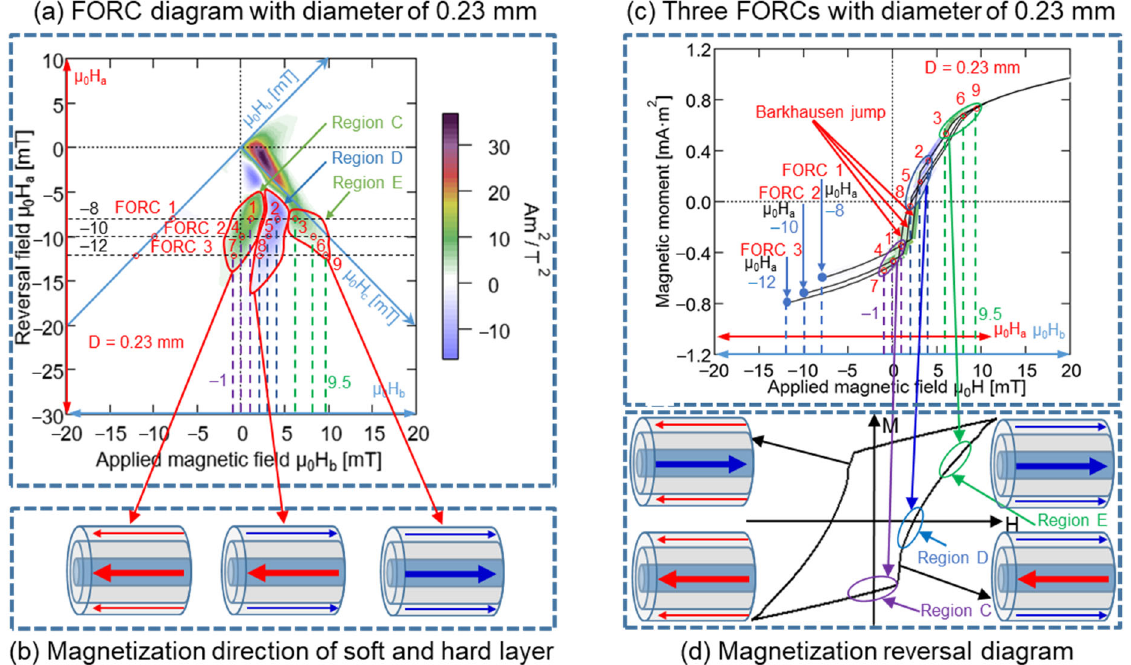
Figure 15. ( a ) FORC diagram for 0.18 mm-diameter Wiegand wire; three FORCs for varying reversal fields μ 0 H a of − 8, − 10, and − 12 mT. ( b ) Magnetization reversal direction of soft and hard layer. ( c ) Three FORCs for 0.18 mm-diameter Wiegand wire for reversal fields of − 8, − 10, and − 12 mT. ( d ) Magnetization reversal diagram of minor loop.